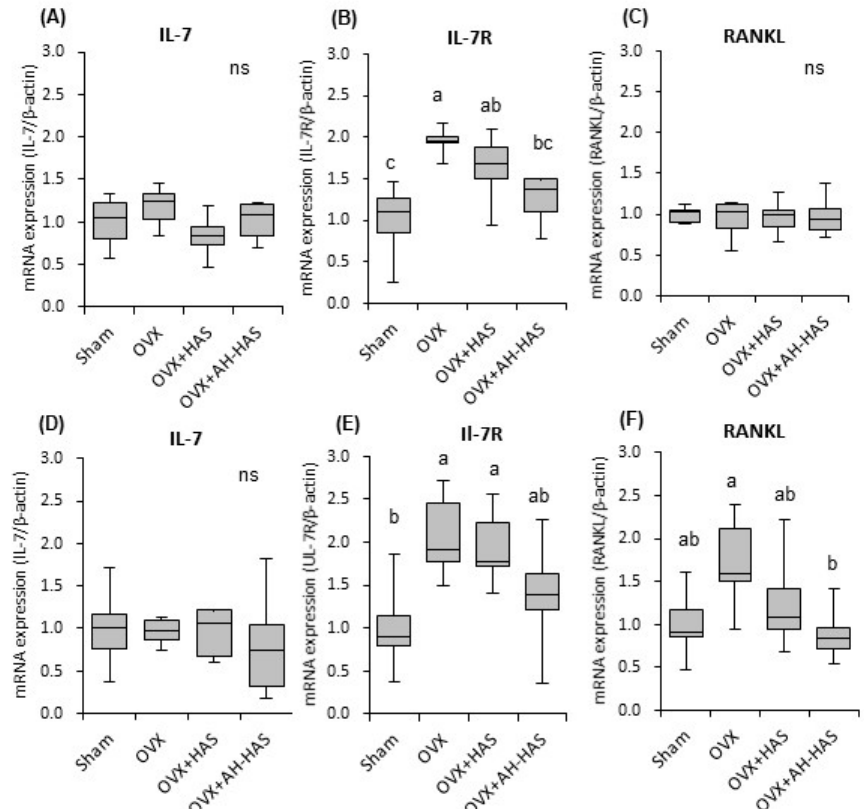
Figure 3. mRNA expression of bone-marrow cells collected from the tibia was measured from sham and OVX mice fed a control diet, 20% high-amylose corn starch (HAS)-supplemented diet (OVX + HAS), or 20% acid-hydrolysed high-amylose corn starch (AH-HAS)-supplemented diet (OVX + AH-HAS) for 14 ( A–C ) or 42 ( D – F ) days. Expression of IL-7 ( A , D ), IL-7R ( B , E ) and RANKL ( C , F ) were determined by qRT-PCR. The ordinate axis indicates the relative amount of mRNA compared with that in sham mice. Gene expression was expressed as the fold-change relative to that of sham mice and normalised to β -actin expression. Values are the mean ± SEM ( n = 8). mRNA expression of bone-marrow cells collected from the tibia was measured using one-way analysis of variance. Differences between treatment groups were assessed by Tukey’s post hoc test. Differences were considered significant if p < 0.05. a, b, c Mean values with unlike letters are significantly different and ns: not-significant.